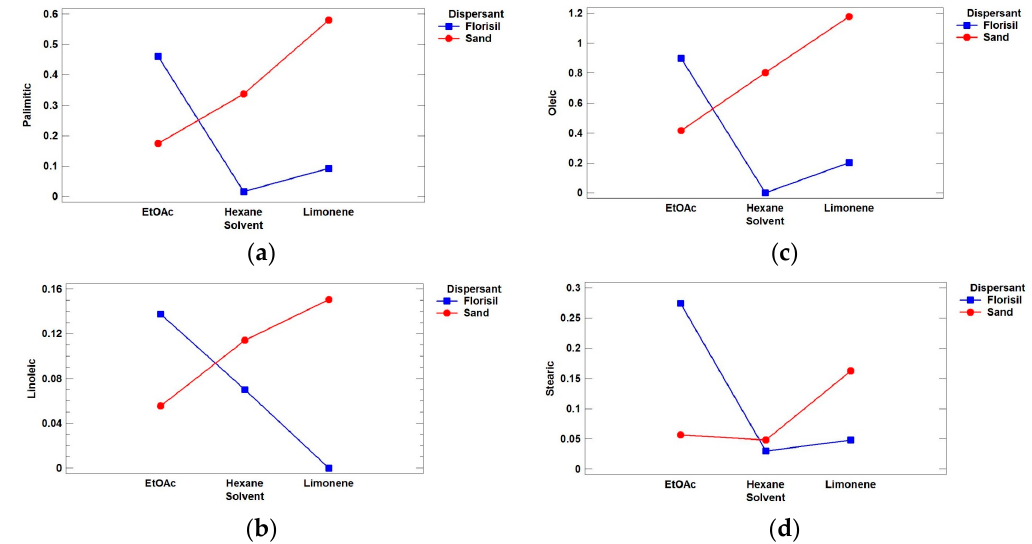
Figure 3. Interaction plots between the adsorbent type and the extraction solvent for the target fatty acids: ( a ) palmitic; ( b ) linoleic; ( c ) oleic; and ( d ) stearic.